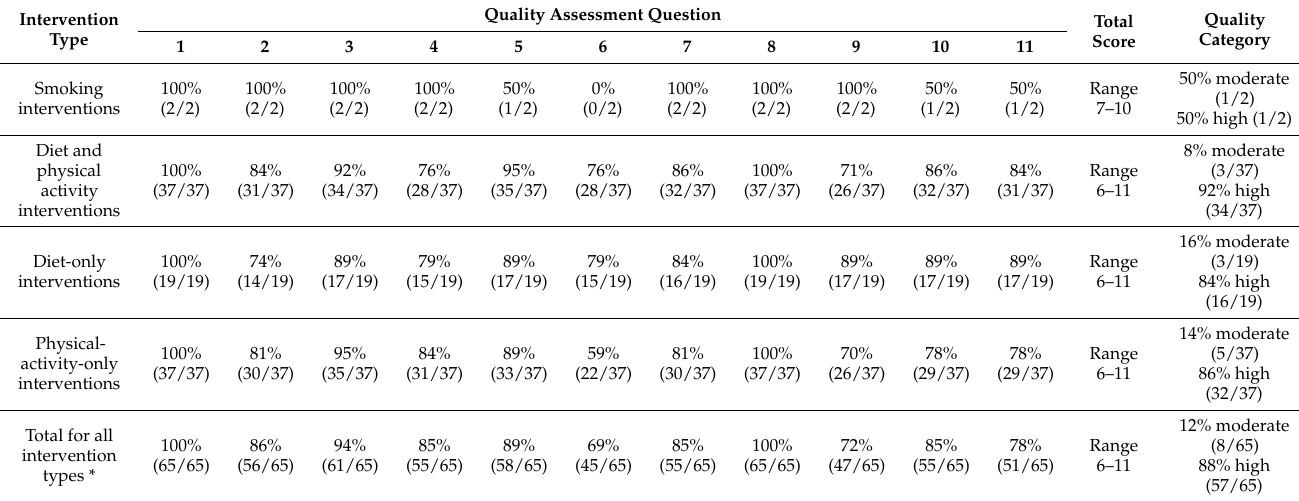
Table 2. Summary of quality assessment of included systematic